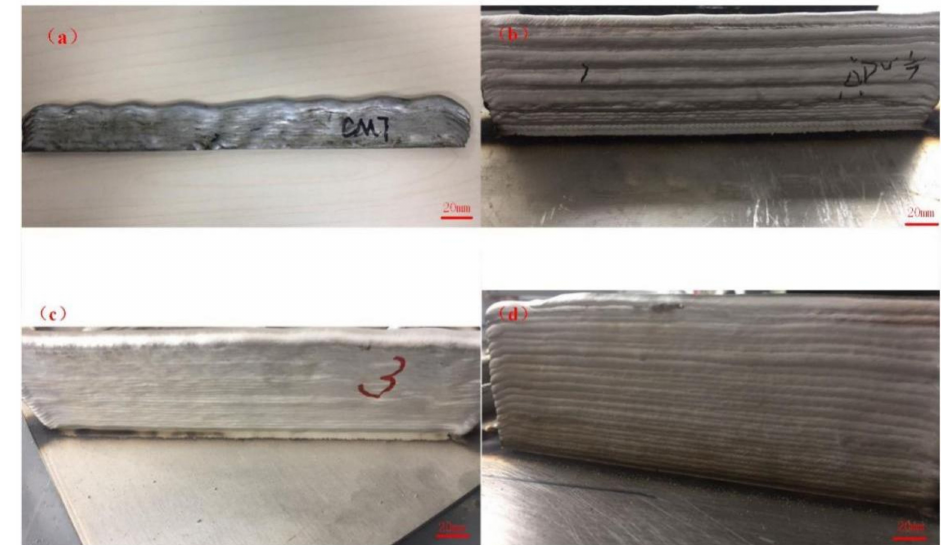
Figure 4. The multilayer additively manufactured 2219 aluminum wall samples using different arc modes: ( a ) CMT; ( b ) CMT-ADV; ( c ) CMT-P, and ( d )